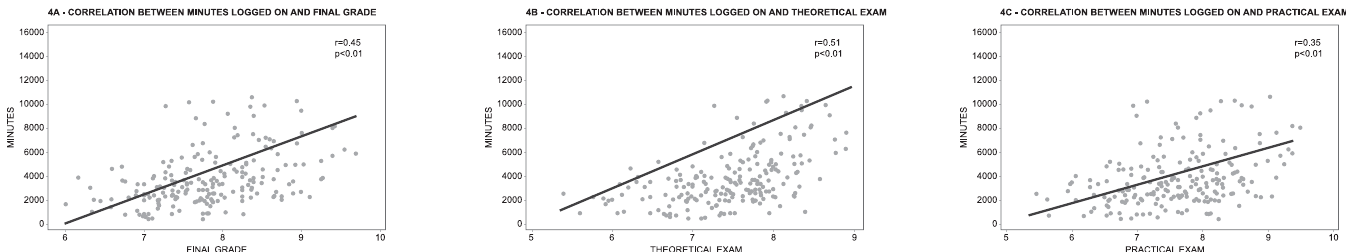
PLOS ONE | DOI:10.1371/journal.pone.0152462 March 31,